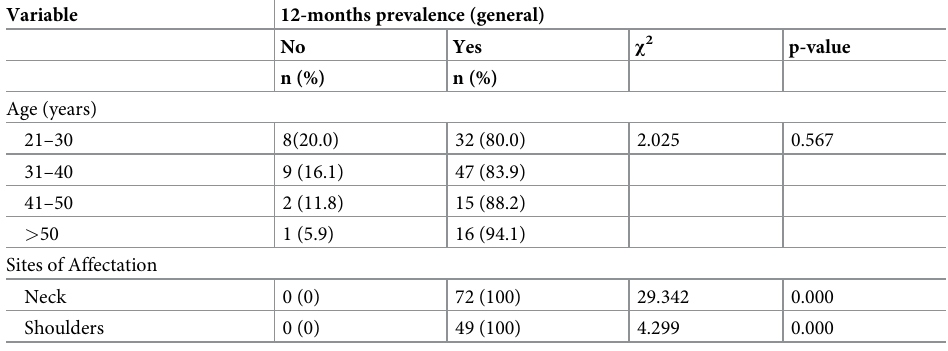
Table 4. Chi-square test of association between twelve-months prevalence of work-related musculoskeletal disor- ders and each of age, sites of affectation, job characteristics and risk factors (N = 130).